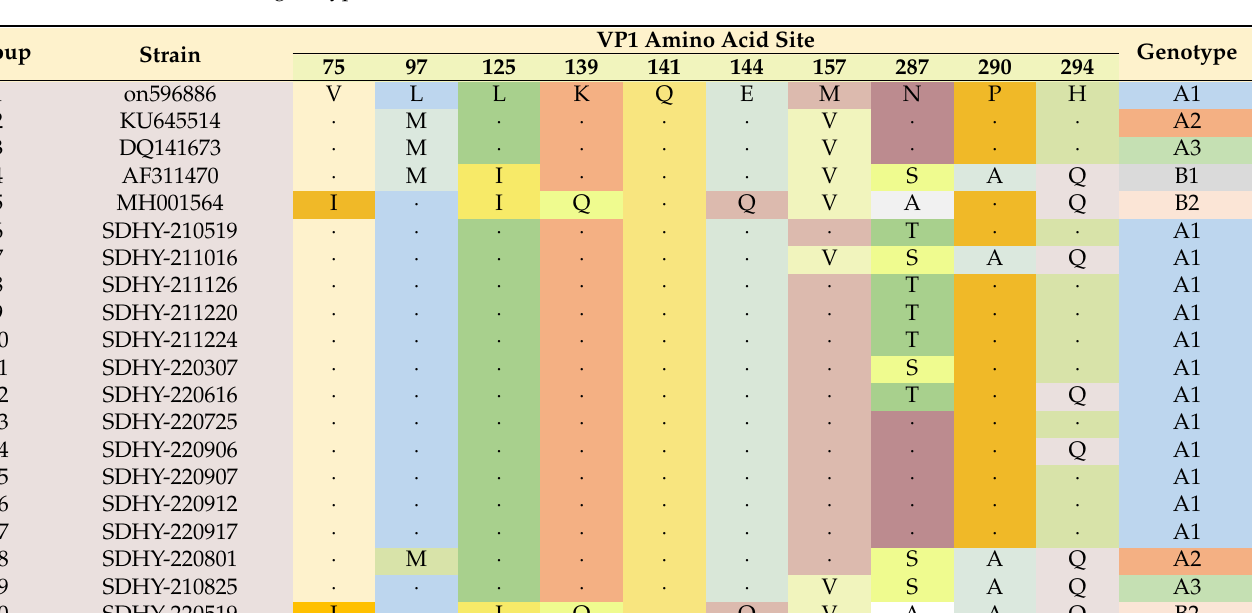
Table 2. The analysis of amino acid substitutions in the VP1 proteins of the isolates and the reference strains. The same color in each column means that the amino acids at the locus are identical or the genotypes are